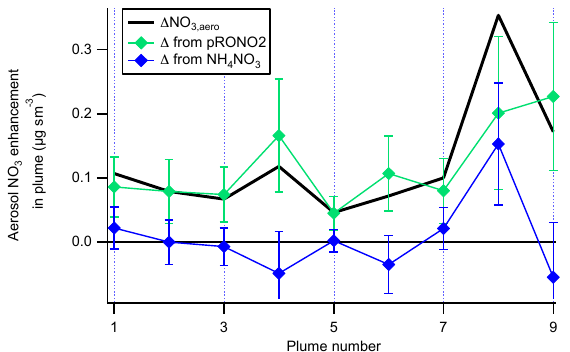
Figure 4. The contribution of each species to the nitrate enhance- ments in each of the plumes, showing that the enhancements in most of the plumes are mainly due to enhancements in organic nitrate, with the exception of Plume 8, which had enhancements in both organic and ammonium nitrate. Error bars are estimated from the measurement variability, the UMR corrections to the nitrate signals, apportionment between organic and inorganic nitrate, and the total nitrate uncertainty (see